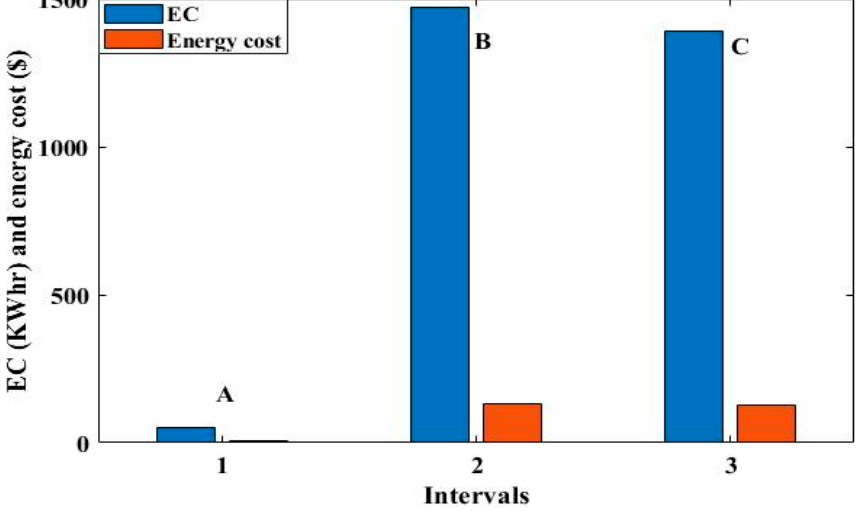
Figure 15. Energy consumption and energy cost of phases A, B, and C.